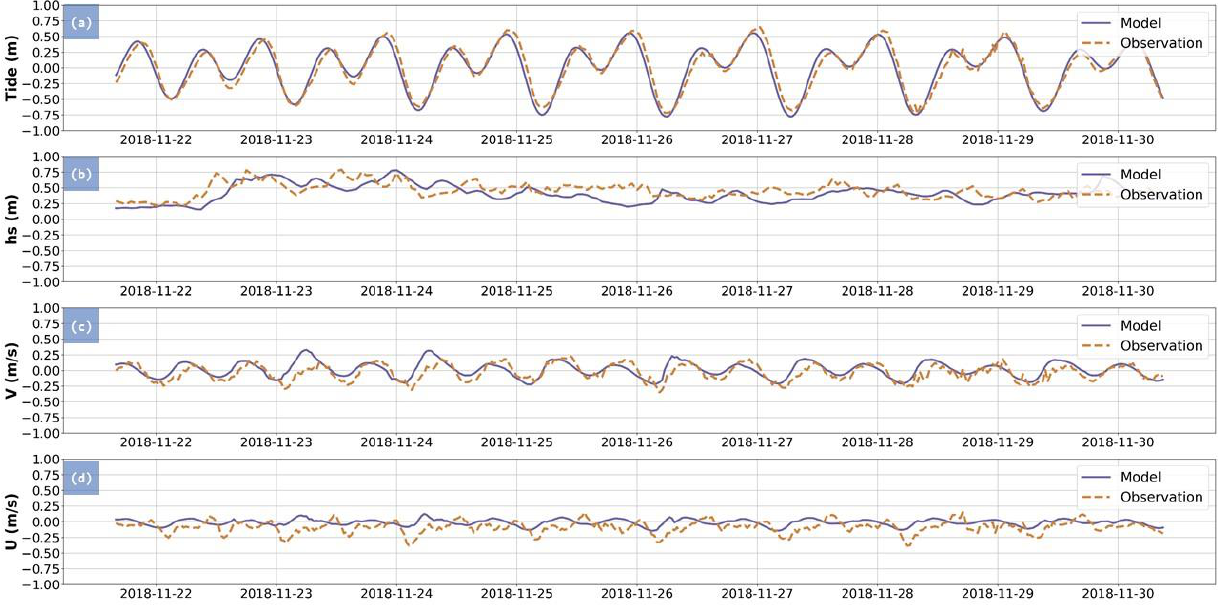
Figure 6. Modeled (blue curves) and measured (red dots) ( a ) surface elevation, ( b ) significant wave heights, ( c ) the north– southward component of the current velocity, and ( d ) the east–westward current component of the current velocity versus time at station C during 21–30 November 2018. Table 1. Model performance of surface elevation, significant wave heights, and current speed for all the sensors (see the location in Figure 2a) during 21–30 Nov 2018.